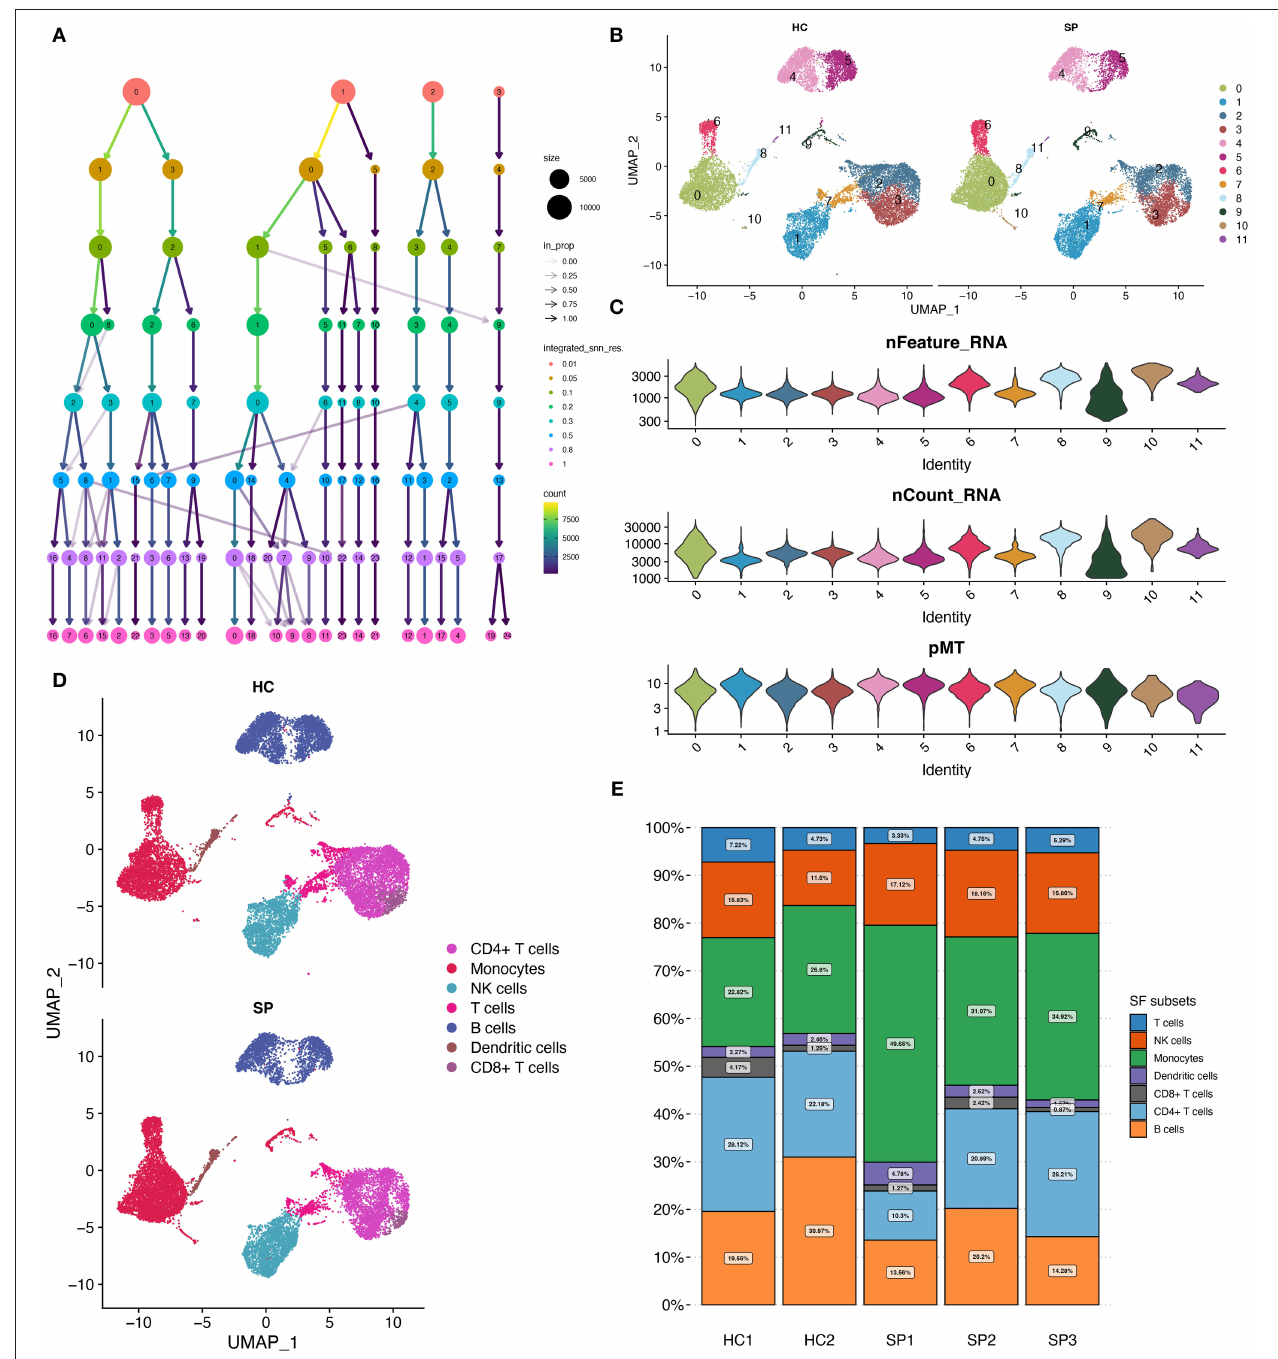
FIGURE 2 | Cell clustering and annotation. (A) Diagram showing the cell clustering process. (B) UMAP showing the distribution of cell clusters, 0–11 indicate different subgroups of cells. (C) Cellular characteristics exhibited by each cell cluster. (D) UMAP showing the annotated cell types in HC and SP. (E) Relative proportion of each cell type between the five samples.